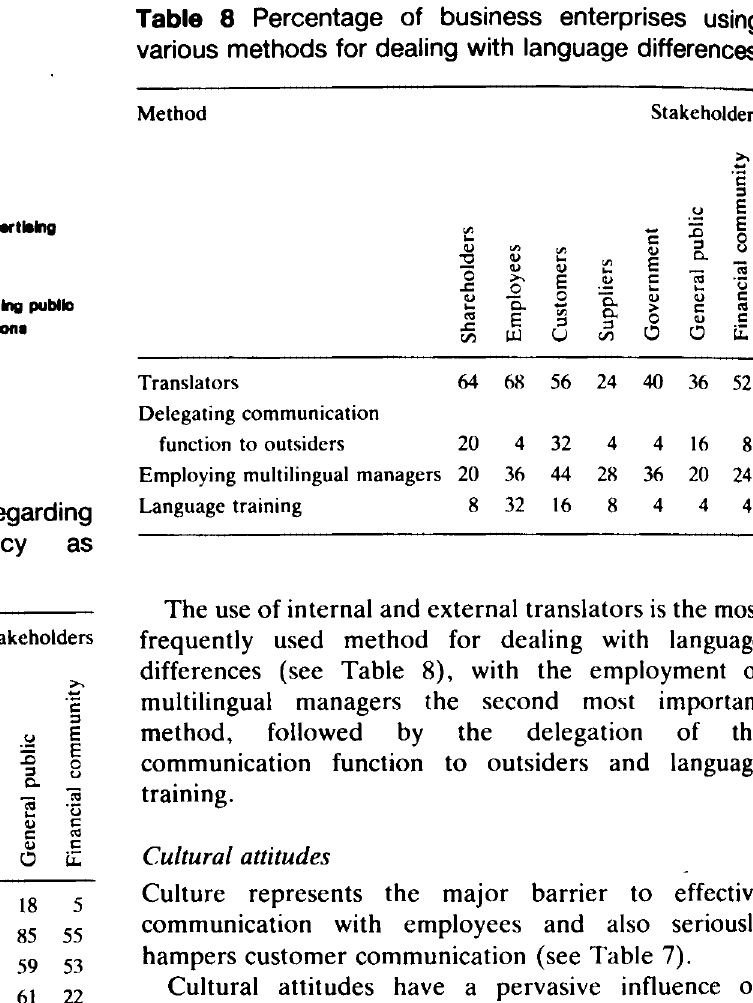
Table 8 Percentage of business enterprises using various methods for dealing with language